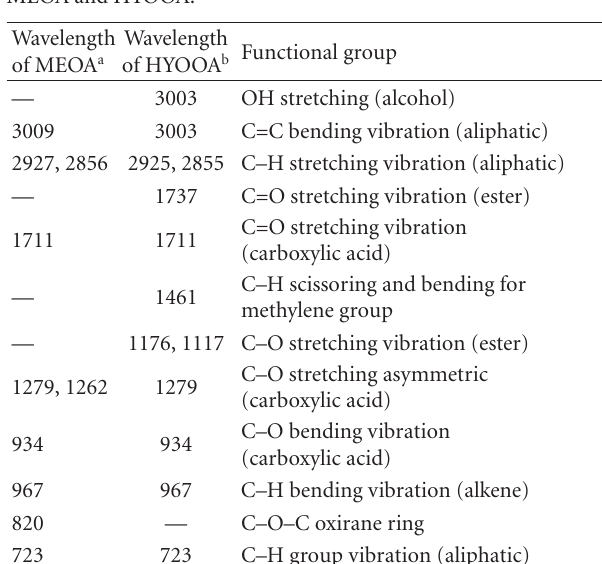
Table 5: The main wavelengths in the FTIR functional groups of MEOA and HYOOA.